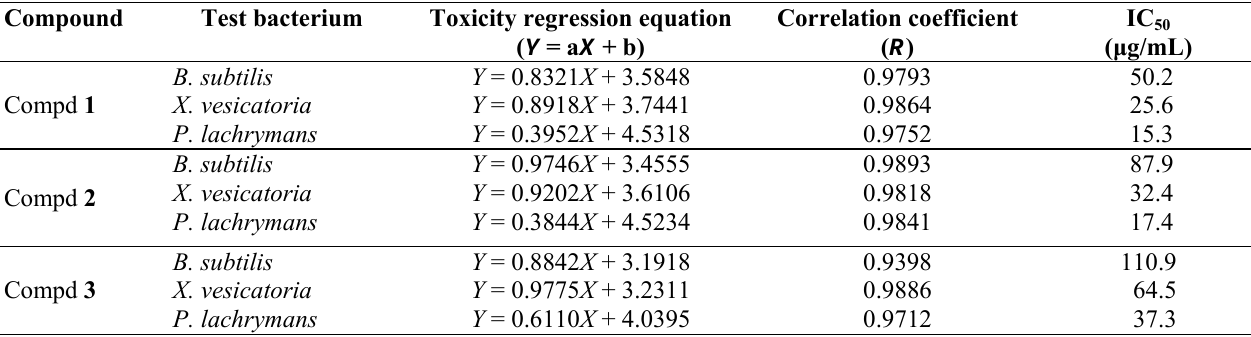
Table 4. Median effective inhibitory concentration (IC pathogenic bacteria